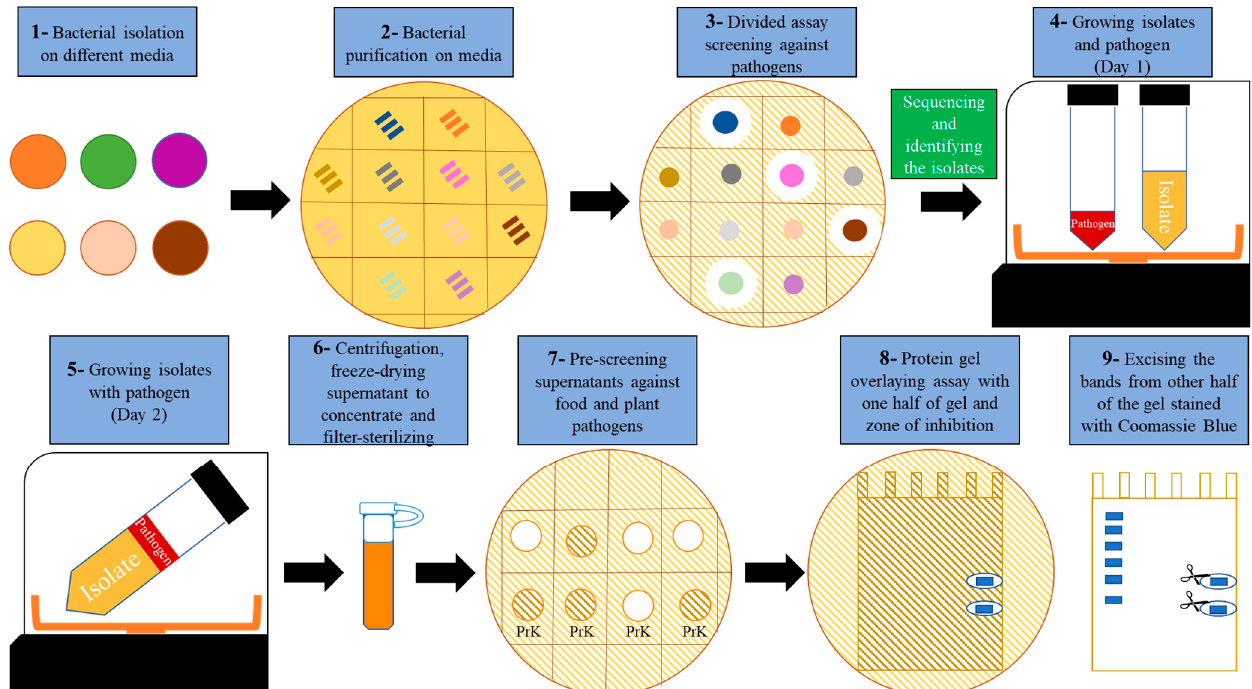
Figure 1. AMC antimicrobial discovery platform. Steps include (1) the isolation of microbes from environmental samples on different media (Supplementary File S1, Table S3), (2) purifying and (3) screening by plate growth inhibition assays using plant and food pathogens (hatched background), (4, 5) the AMC induction method by co-cultivation with living Gram-positive and -negative pathogens at 28 °C, (6) centrifugation and concentration of cell-free supernatants by freeze-drying, (7) testing of the concentrated supernatants with or without proteinase K to distinguish between AMPs and AMMs, followed by (8) peptide gel microbial growth inhibition assays to (9) extract bioactive peptides and MS/MS of trypsin-digested peptides or coculture supernatant fractionation by HPLC (high-performance liquid chromatography) followed by MS/MS (tandem mass spectrometry) or GC/MS (gas chromatography–mass spectrometry) analysis.